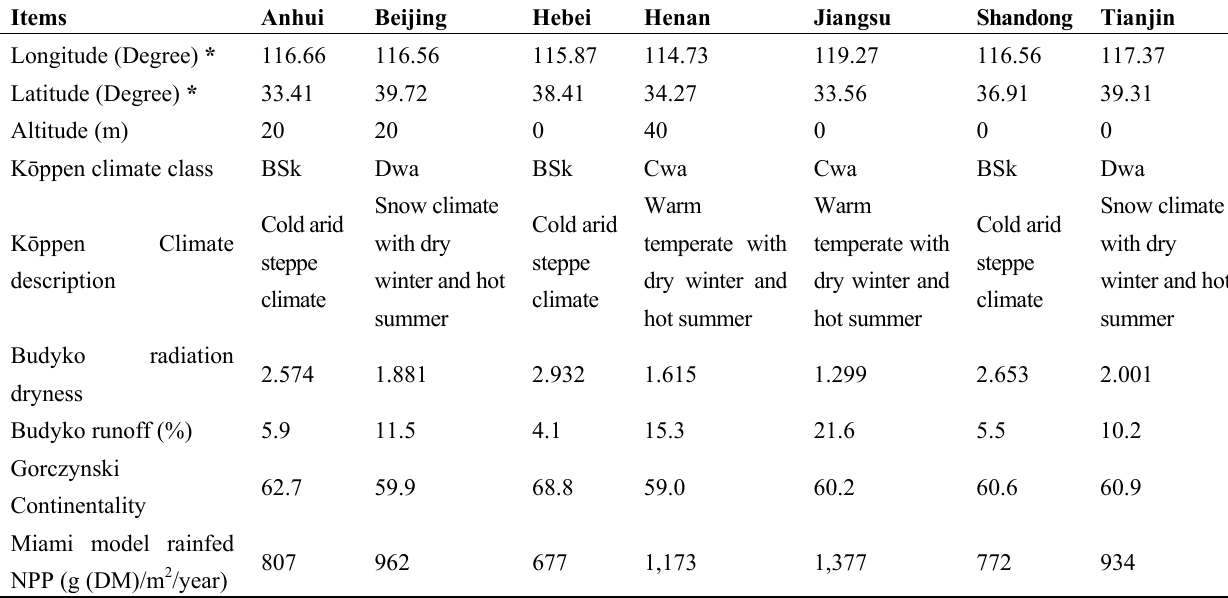
Table 1. Climatic characteristics of the North China Plain (NCP)